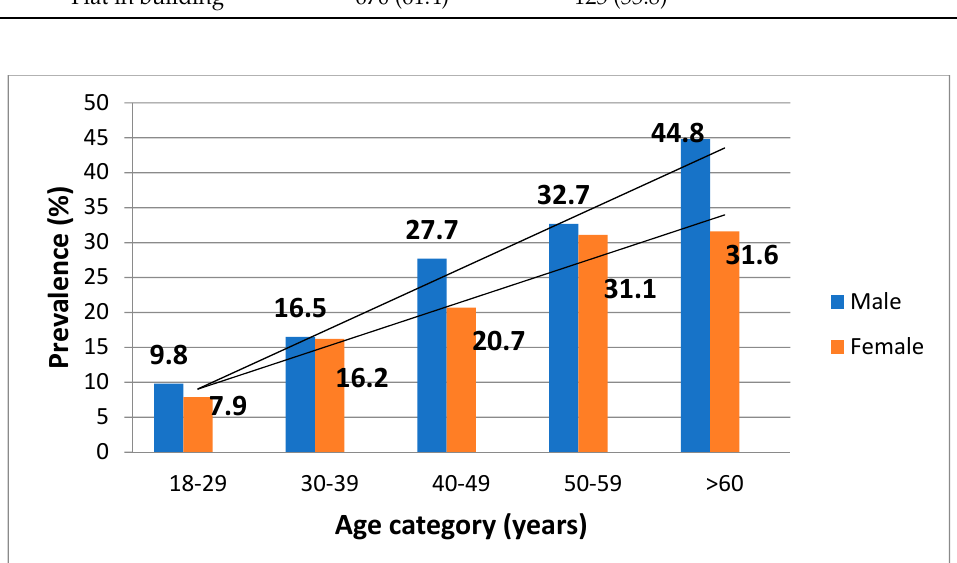
Figure 1. Prevalence of T. gondii infection in female and male donors according to age category.